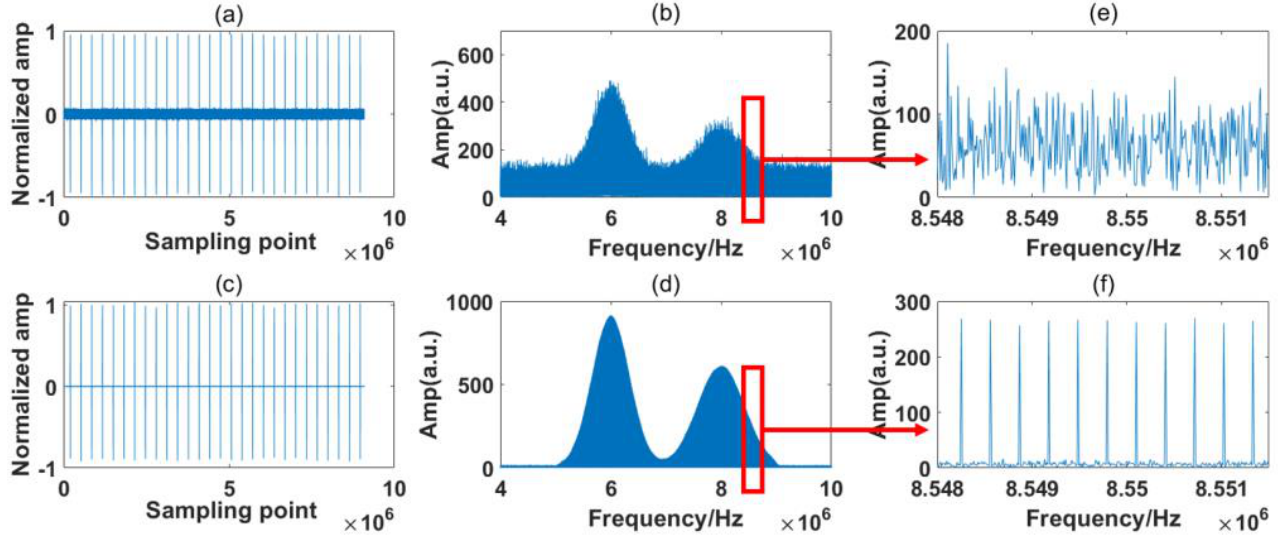
Figure 5. Simulation of the reference path signal. ( a ) Raw time domain signal; ( b ) raw frequency domain signal; ( c ) corrected time domain signal; ( d ) corrected frequency domain signal; ( e ) Magnified view of red rectangle shown in ( b ); ( f ) Magnified view of red rectangle shown in ( d ).